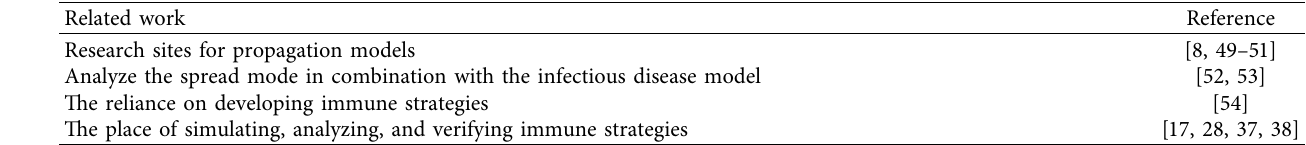
Table 2: The work done on infectious diseases using the small world network: in the related work column, the research studies performed by researchers using the small world network are shown, and in the reference column is the relevant literature of the corresponding research.